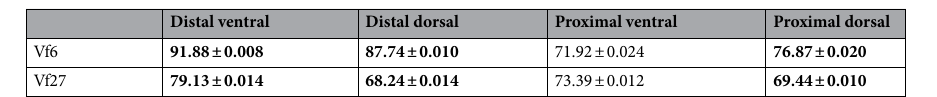
Table 6. Percentage of lignin cell occupation in the faba bean parental lines Vf6 and Vf27, measured in different pod zones. Significant differences according to ANOVA are indicated in bold ( P <